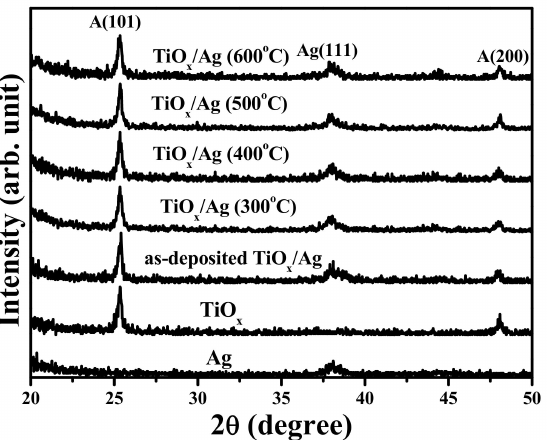
Figure 7. XRD spectra of the as-deposited and annealed TiO x /Ag structures as well as the TiO x and Ag films.